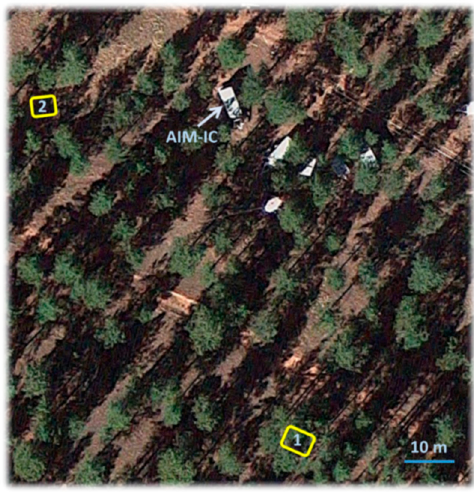
Figure 1. Bird’s-eye view of the research site, with AIM-IC and soil sampling locations (\sites 1 and 2) marked.